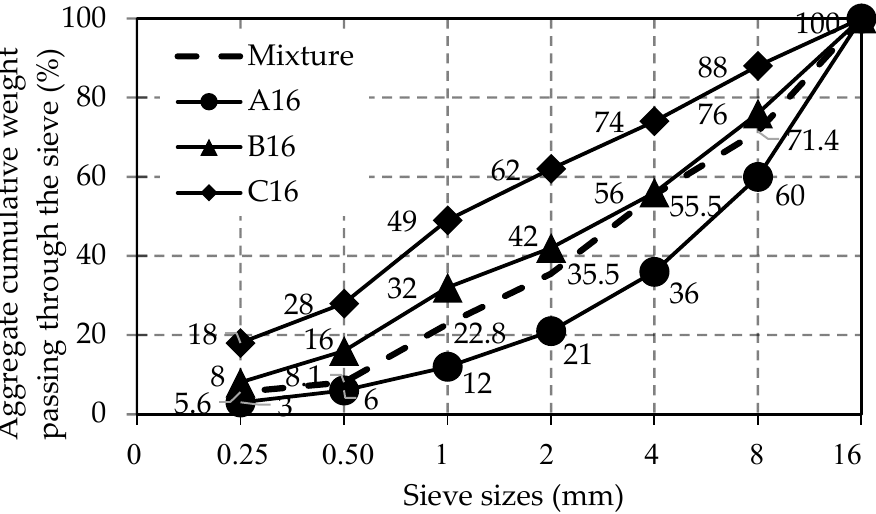
Figure 6. Sieve distribution of the mixture aggregate (A16, B16 and C16 are reference curves given by TS 706 [29]). Table 2. Mix proportion of concrete.